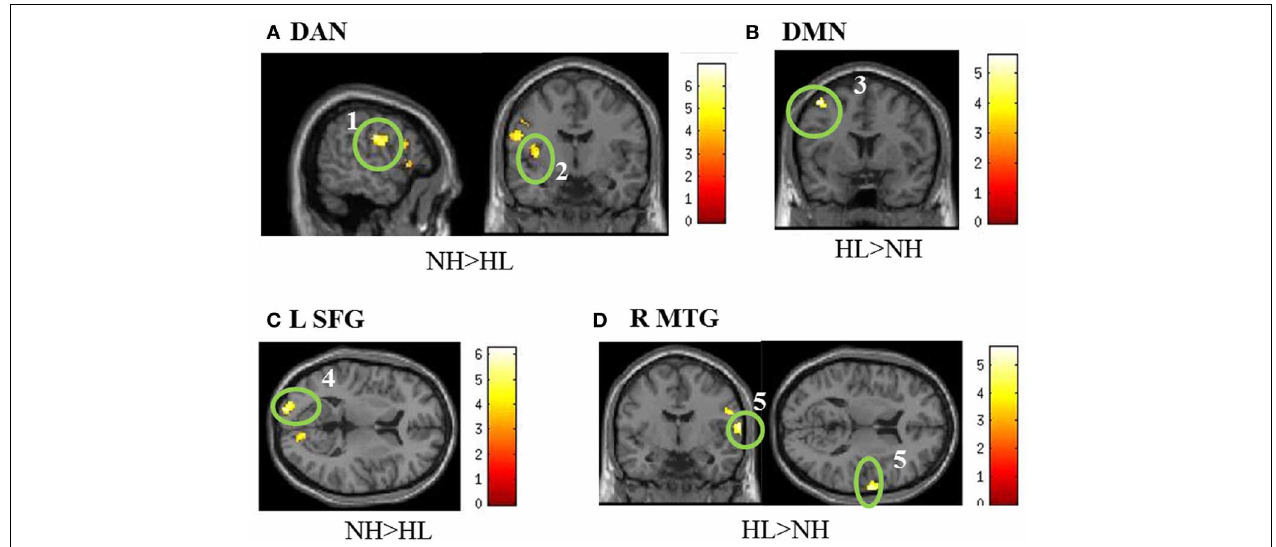
FIGURE 4 | Statistical parametric maps of the two-tailed two sample t -tests of the resting state functional connectivity results. (A,B) show the results of the seeding analyses designed to examine the connectivity of the resting state networks, while (C,D) show correlations to the task-based seeds. The maps are displayed at p < 0 . 001 uncorrected level for better visualization, but the clusters in the circles are corrected for multiple comparisons ( p < 0 . 025 FWE). In (A) , the seed regions were located in the bilateral posterior intraparietal sulci and the bilateral frontal eye fields to examine connectivity in the